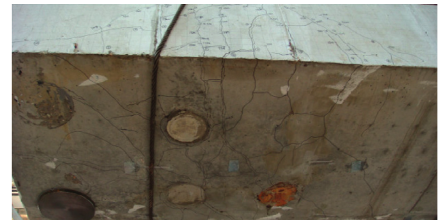
Figure 11: Crack diagram of